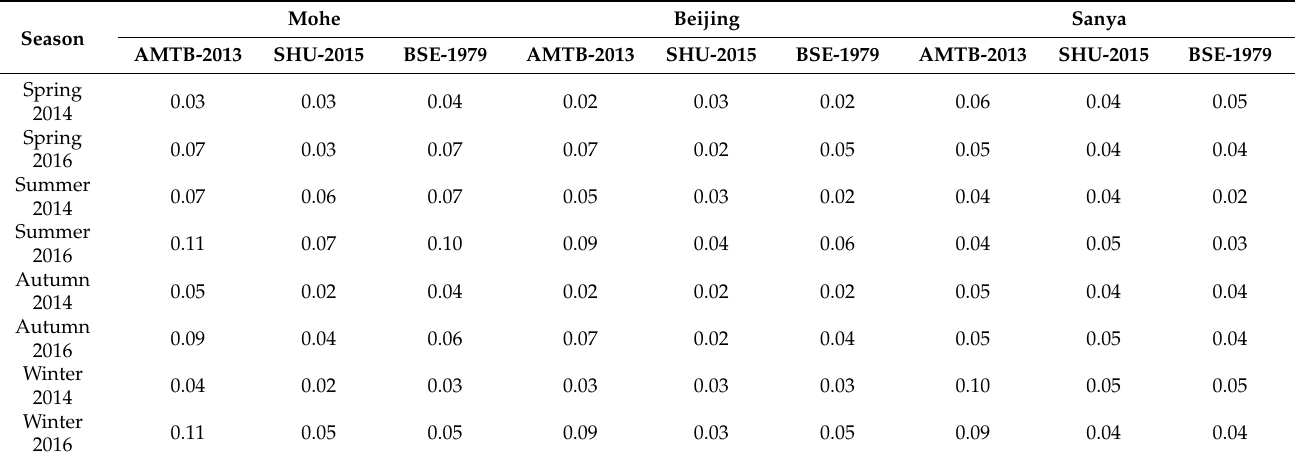
Table 6. Daily average MARE values of IRI-2016 AMTB-2013, SHU-2015 and BSE-1979 predicted hmF2 from the hmF2 ionosonde observed in the four different seasons for the years 2014 and 2016 at Mohe, Beijing and Sanya over